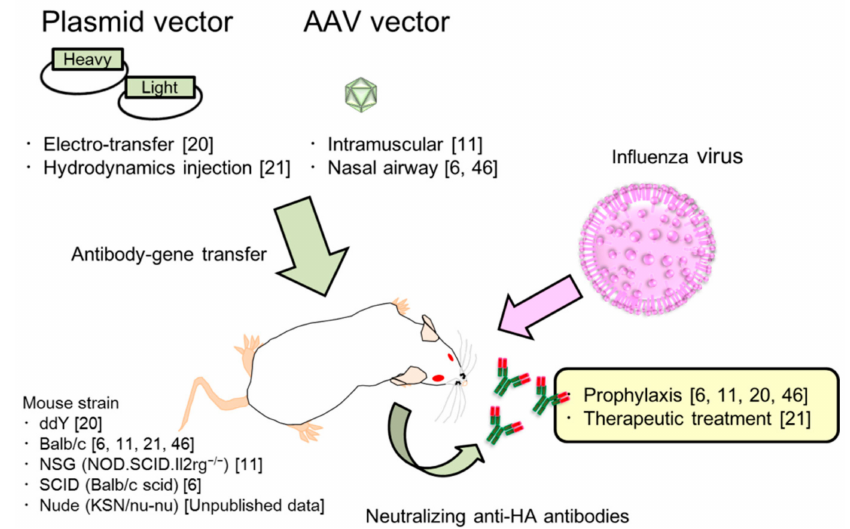
Figure 1. Strategy for the protection against influenza by passive-immunotherapy with antibody gene